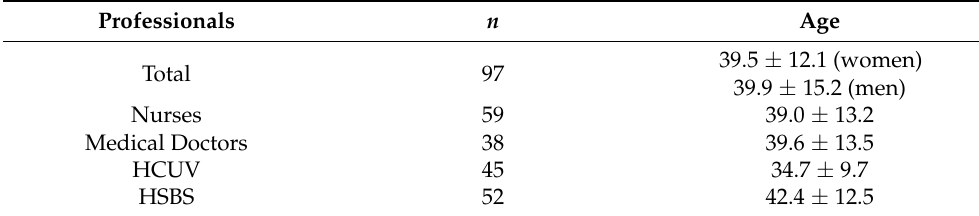
Table 1. Professional groups and mean age ± SD of